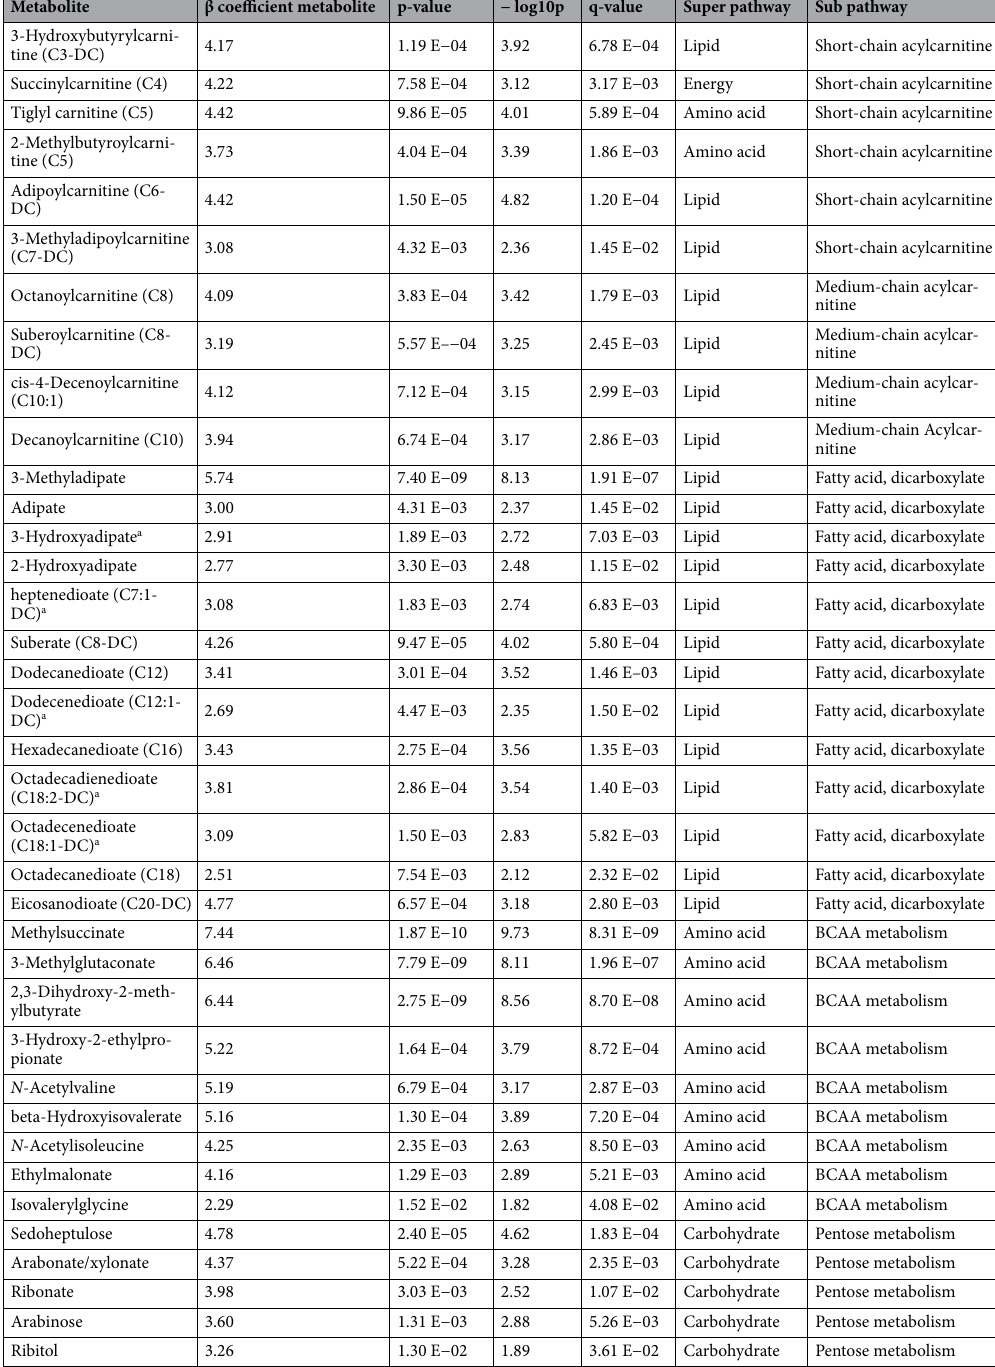
Table 2. Metabolites significantly increased with increased Procalcitonin over days 0–7. Using repeated measures data (day 0, 3 and 7), the association between relative quantitation of each individual metabolite noted above and Procalcitonin levels over time were determined utilizing linear mixed-effects models correcting for age, sex, baseline 25(OH)D, absolute increase in 25(OH)D, SAPS II, admission diagnosis, plasma day and an individual subject-specific random-intercept. All significant mixed-effects associations have false discovery rate adjusted p-value (q-value) < 0.05. BCAA is Branched-Chain Amino Acids inclusive of Leucine, Isoleucine and Valine. For the Acylcarnitines sub pathway: a capital C is followed by the number of carbons within the fatty acyl group attached to the carnitine. A colon followed by a number is one or more unsaturated carbons in the acylcarnitine ester (i.e. C10:1 is a monounsaturated C10 acylcarnitine). DC following the carbon number is a dicarboxylic acylcarnitine. a Putative identification (Level 2) where predictive or externally acquired structure evidence is present when a reference standard does not